Question: Briefly state, in one sentence, what is plotted here.
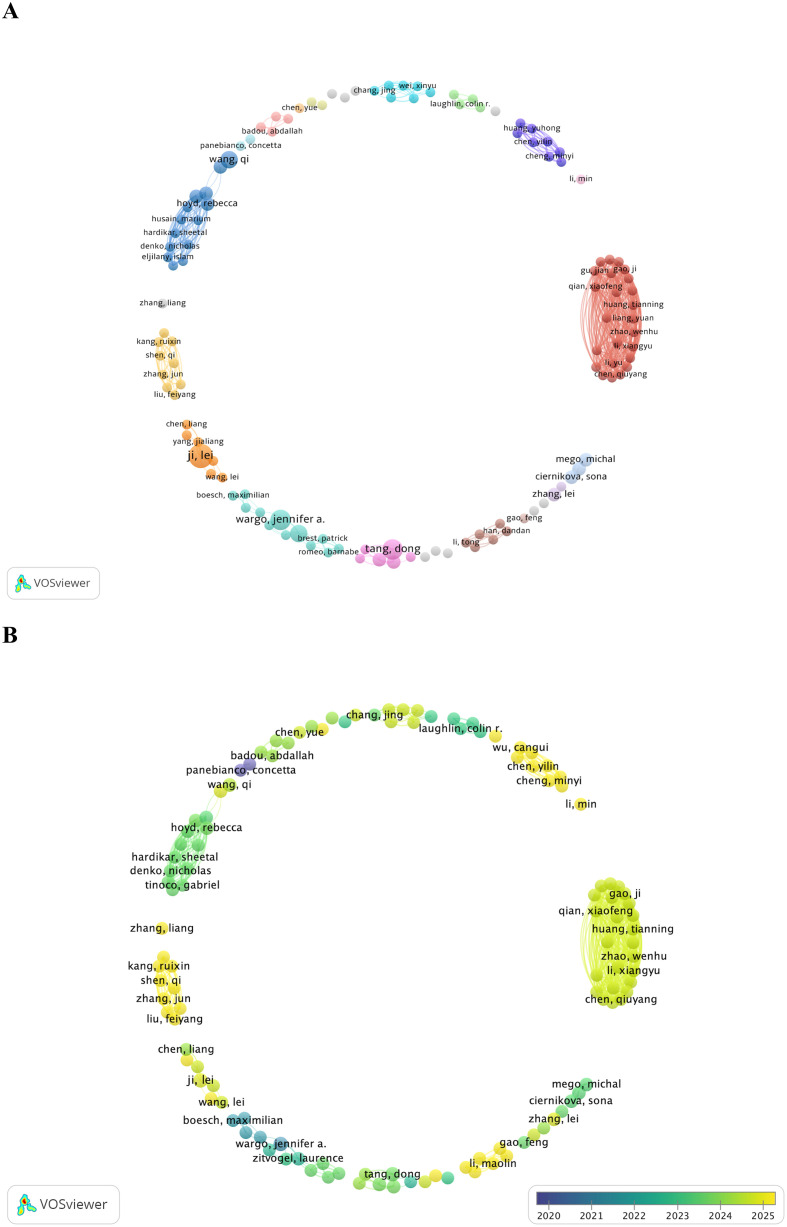
Answer: Author collaboration patterns and temporal evolution. (A) Collaboration network of core authors with at least two publications. Node size is proportional to publication output. Edge thickness represents collaboration strength. Node colors indicate distinct collaboration clusters identified. (B) Temporal overlay of the author collaboration network. Node color gradient from blue (earlier average publication year) to yellow (later average publication year).